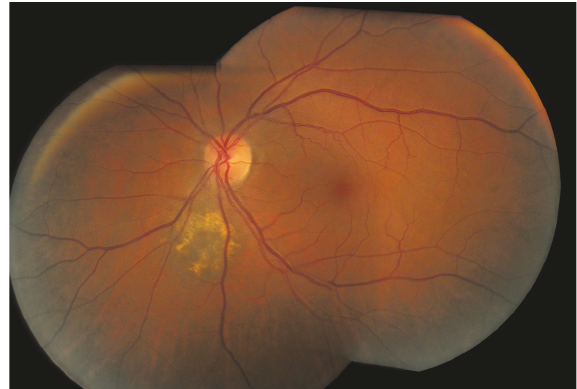
Figure 1: Fundus photography OS shows juxtapapillary pigmented choroidal nevus.